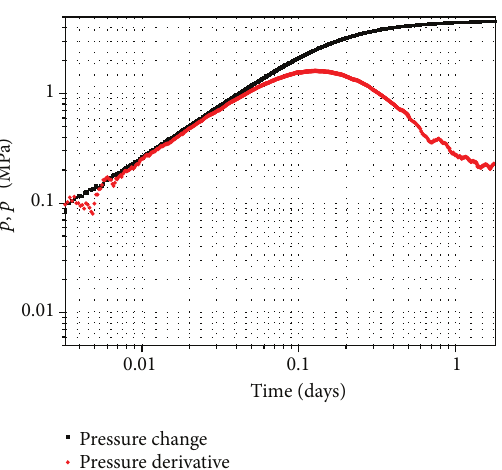
Figure 9: Computational domain for the real example.